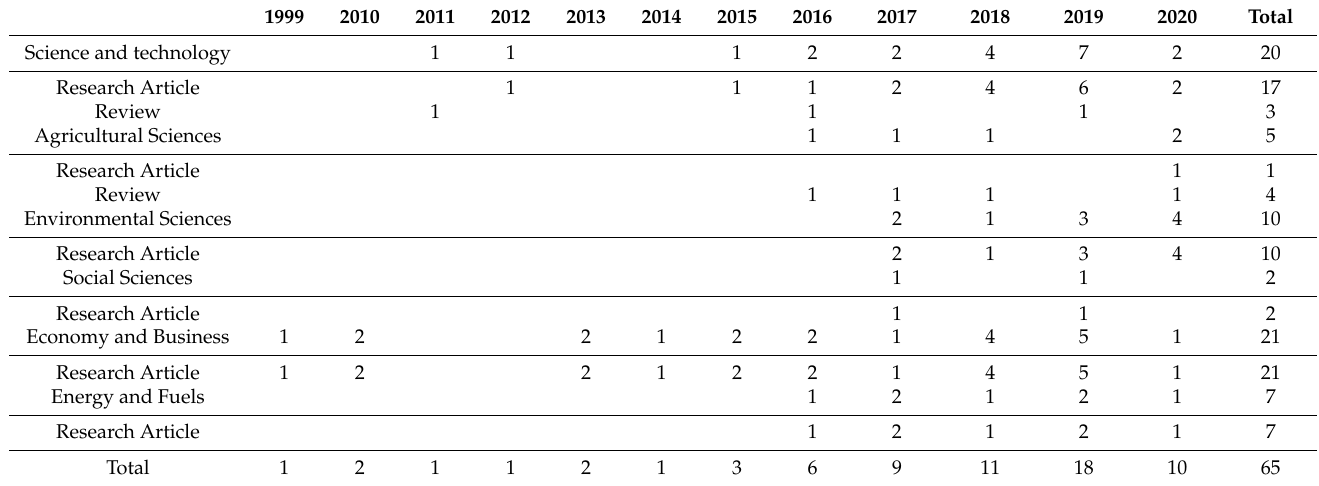
Table 4. Evolution of publications in research